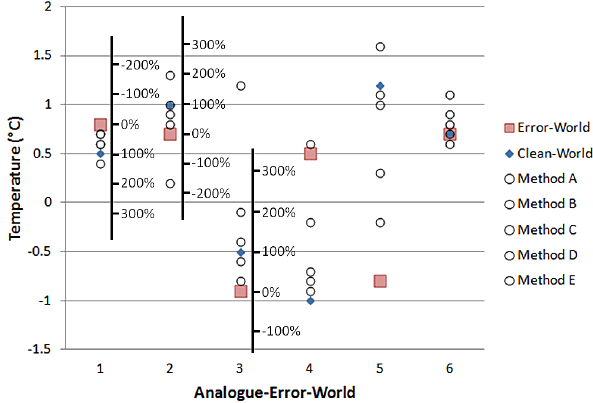
Figure 2. Example summary graph of algorithm skill for five hy- pothetical methods across six analogue-error worlds measured as trend-percentage recovery. This uses the trends calculated from an adjusted analogue-error world scaled against the difference be- tween the analogue-error world and its corresponding analogue- clean world. A 100% trend recovery would indicate a perfect algo- rithm. Greater than 100% would be moving the trend too far in the right direction. Less than 100% would be an algorithm that does not move the trend far enough towards the analogue-clean world. A negative percentage would indicate an algorithm that moves the trend in the wrong direction. This method does not indicate algo- rithms that result in a trend of the wrong sign (positive or negative). This may be seen as a more serious problem than a trend being over- or underestimated and so would need to be identified